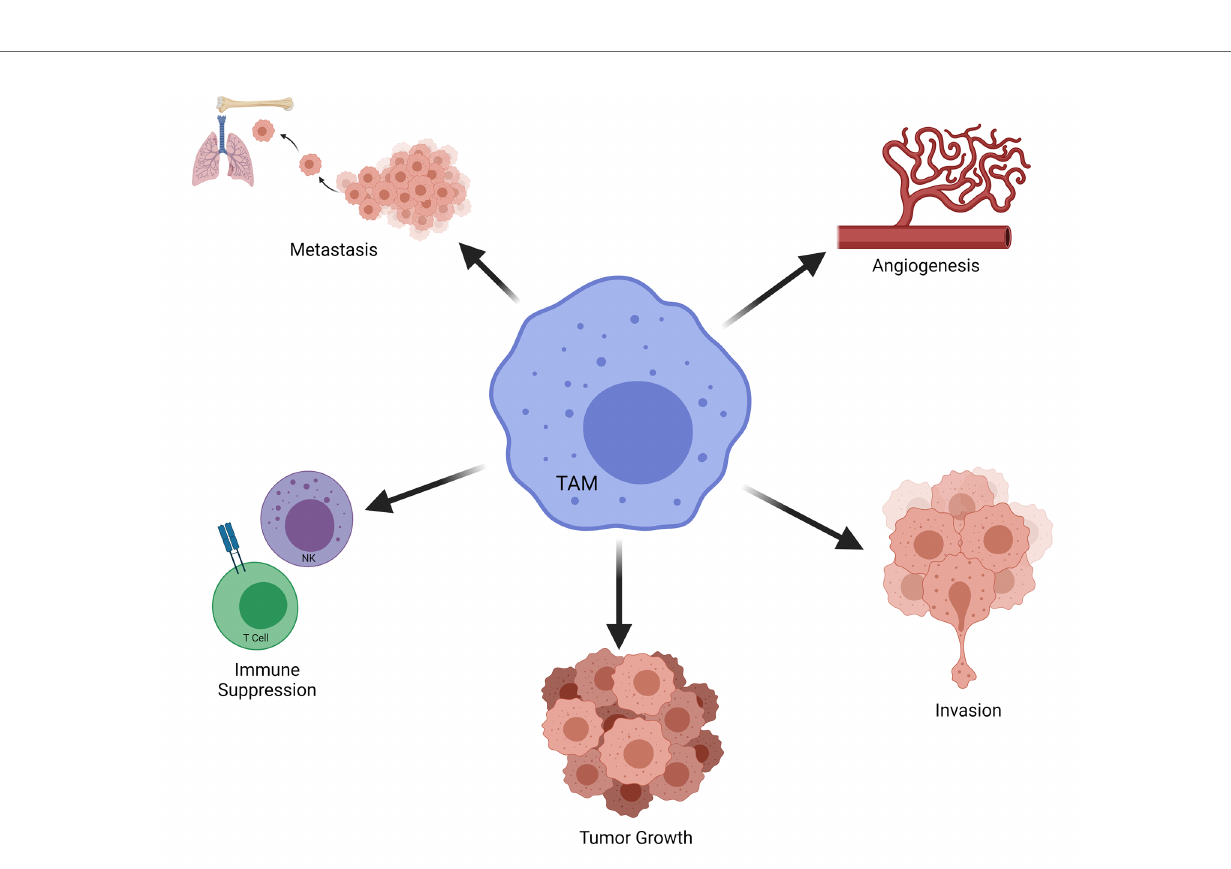
Frontiers in Oncology |